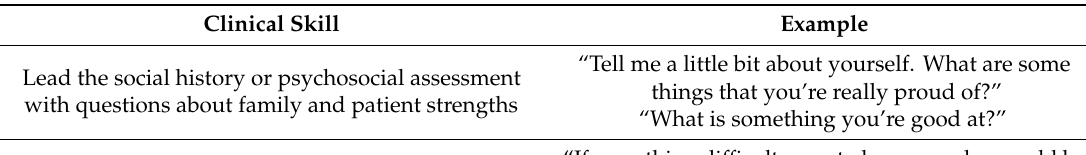
Table 1. Strengths-based approach to care: clinical